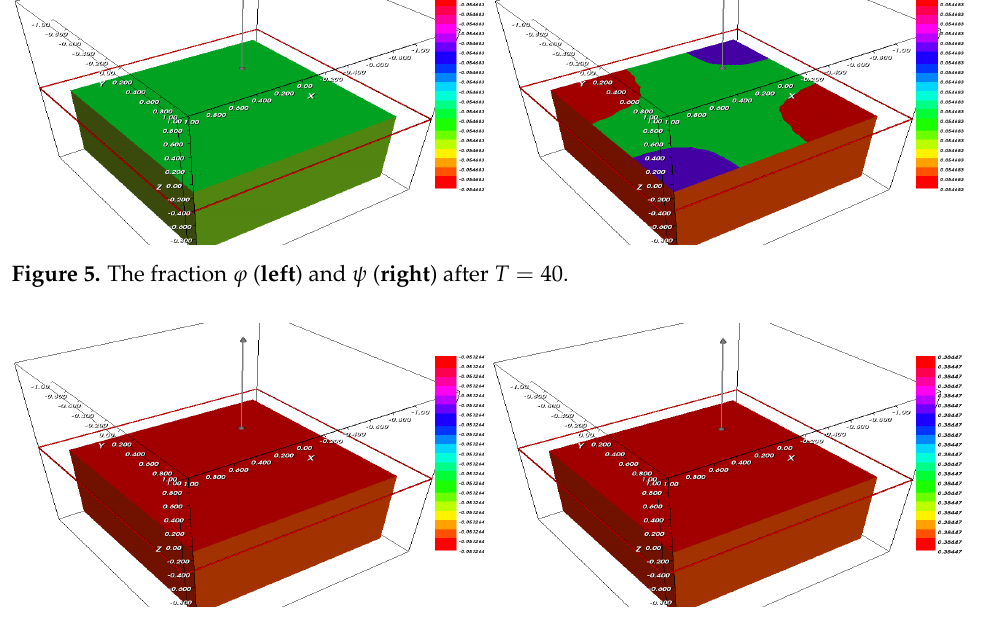
Figure 6. The fraction ϕ ( left ) and ψ ( right ) after T = 50.